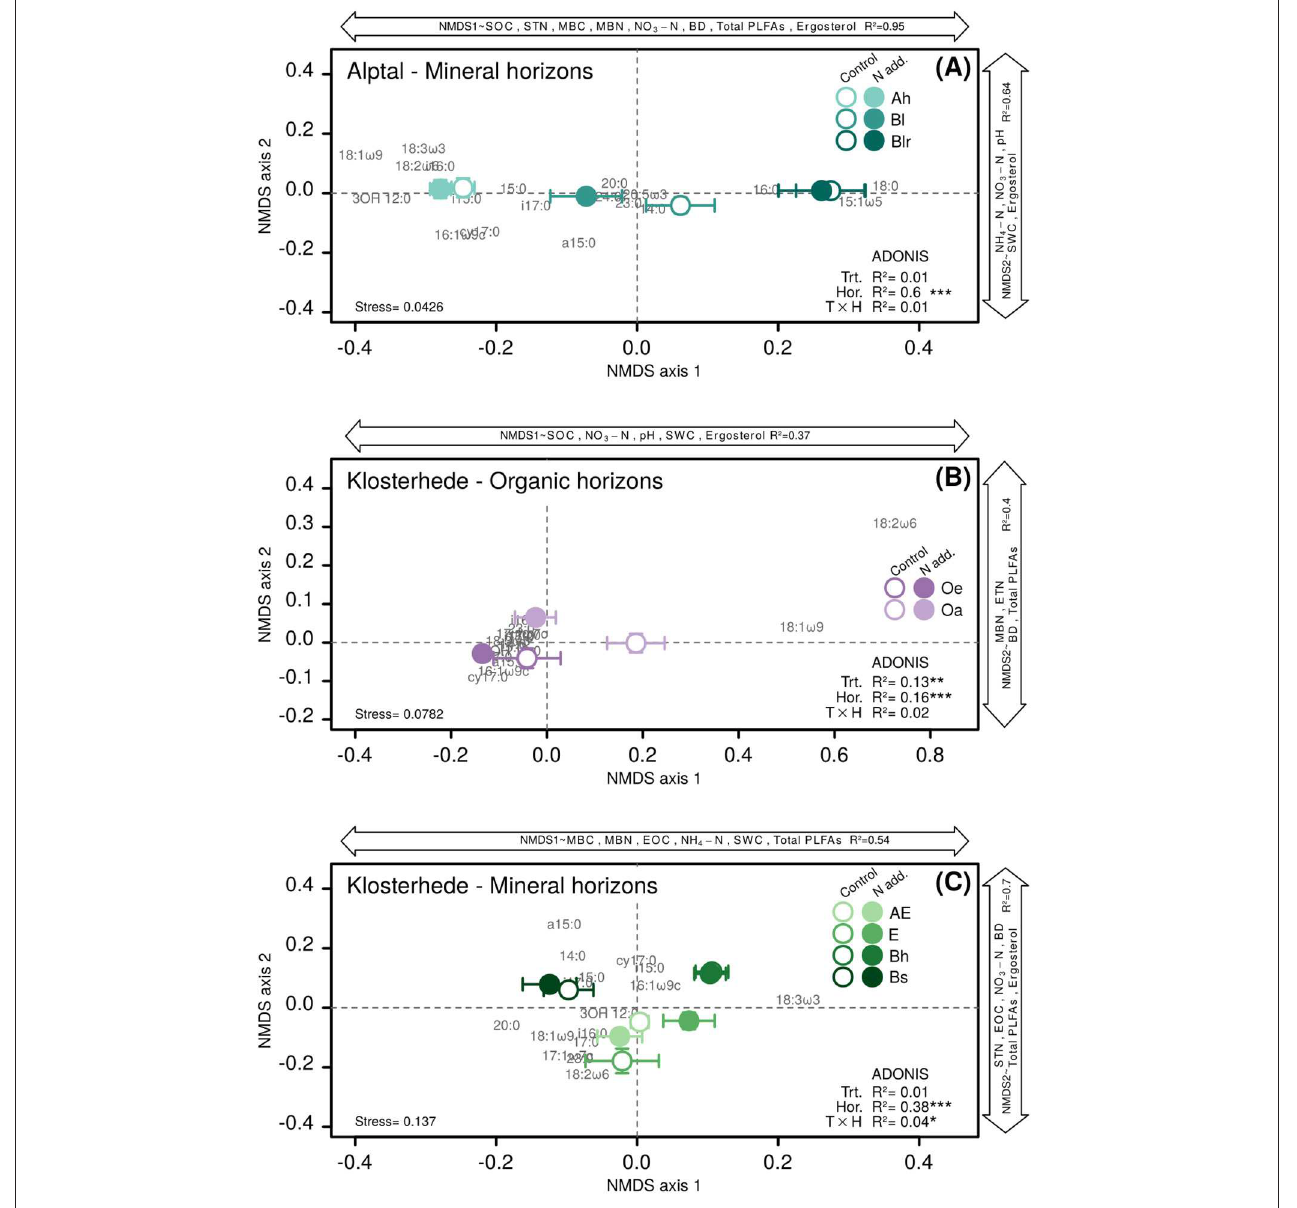
FIGURE 3 | Non-metric multidimensional scaling (NMDS) ordinations based on distance-matrices calculated from PLFA biomarkers of control and N addition plots at Alptal (A) and Klosterhede (B,C) . Double-headed arrows parallel to NMDS axes depict variables significantly related to the respective axis by multiple linear regression. Each ordination only includes PLFA markers with a relative abundance > 0.5 mol% in at least 80% of samples (see Tables S1 , S2 ). See Materials and Methods for assignment of PLFA biomarkers to microbial groups. Effects of N addition treatment, soil horizon and their interaction on multivariate PLFA biomarker distances were assessed by permutational analysis of variance